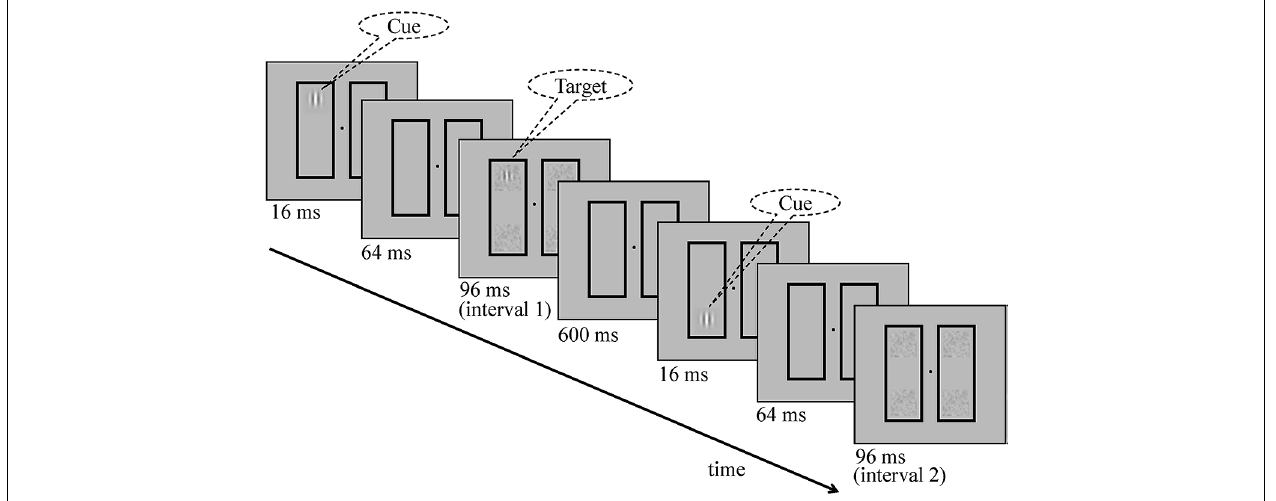
FIGURE 1 | Schematic overview of a typical valid trial with the target showing in interval 1. The task was to detect the target (a Gabor patch) superimposed on different levels of noise (mask) contrast in a two-alternative forced-choice paradigm. In each interval, a cue was flashed